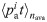
The probability of activation of the reduced networks versus the original networks.The reduction methods generated the activation probability for the reduced networks, and keep the tendency with the FS. (A) The activation probabilities 〈pait〉nava of the reduced networks for the three cases, K = 10 (red), 100 (blue) and 1 000 (black). The inset shows the collapsed curves adopting (〈pait〉nava−0.5)(K)1/2. (B) Example of the tendency between the 〈pait〉nava and the FS for the original network with K = 10. Both were normalized by the area under the curve.